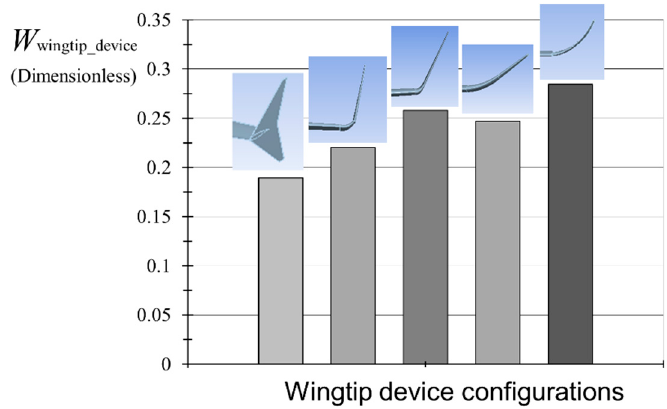
Figure 23. Comparison of values of the dimensionless criterion W Tip_device for different wingtip devices installed on DLR-F4, revealing the relative aerodynamics-to-weight efficiency for each of the devices.